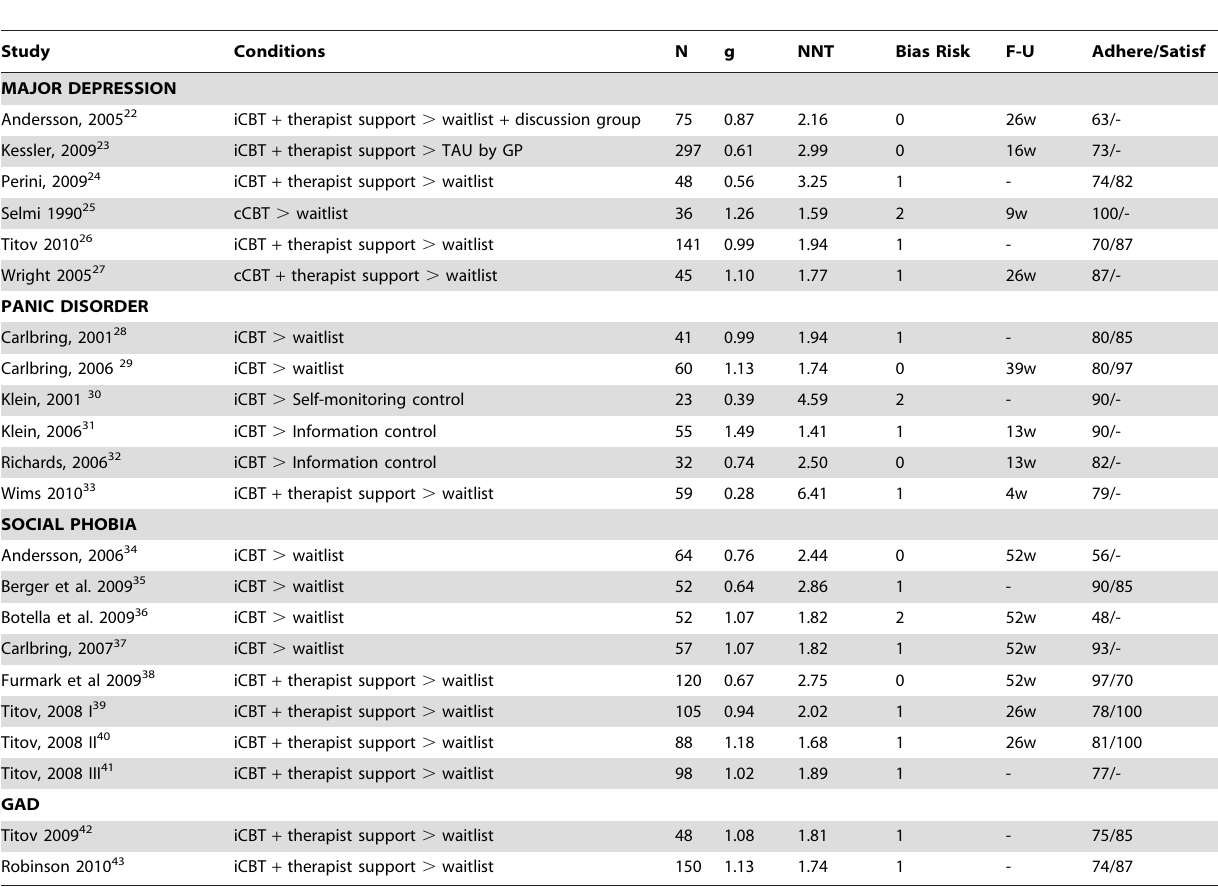
Table 1. Selected characteristics and results of randomized controlled studies examining the effects computerized and internet- based cognitive behaviour therapy for adult depression and anxiety disorders.